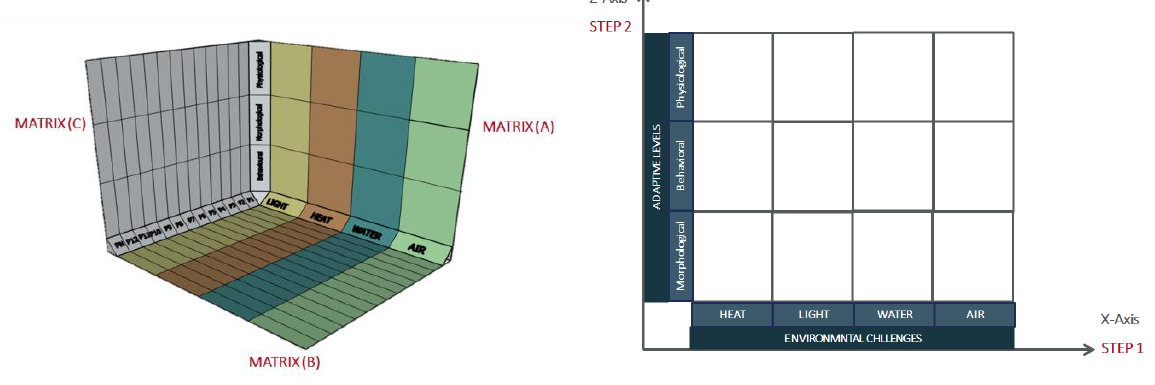
Figure 9 : on the left: 3d Heuristic Model proposal, On right : Matrix A: The relation between the desired type of regulation, and the desired adaptive level (The researcher, 2020) This design methodology is formed out of two main layers discussed earlier. Each layer consists of a series of steps that are interconnected where each step leads to the step that follows. Layer 1 is related to the environmental factors that need to be regulated within the envelope, Figure 10. This layer is formed up of two steps which are as follows: